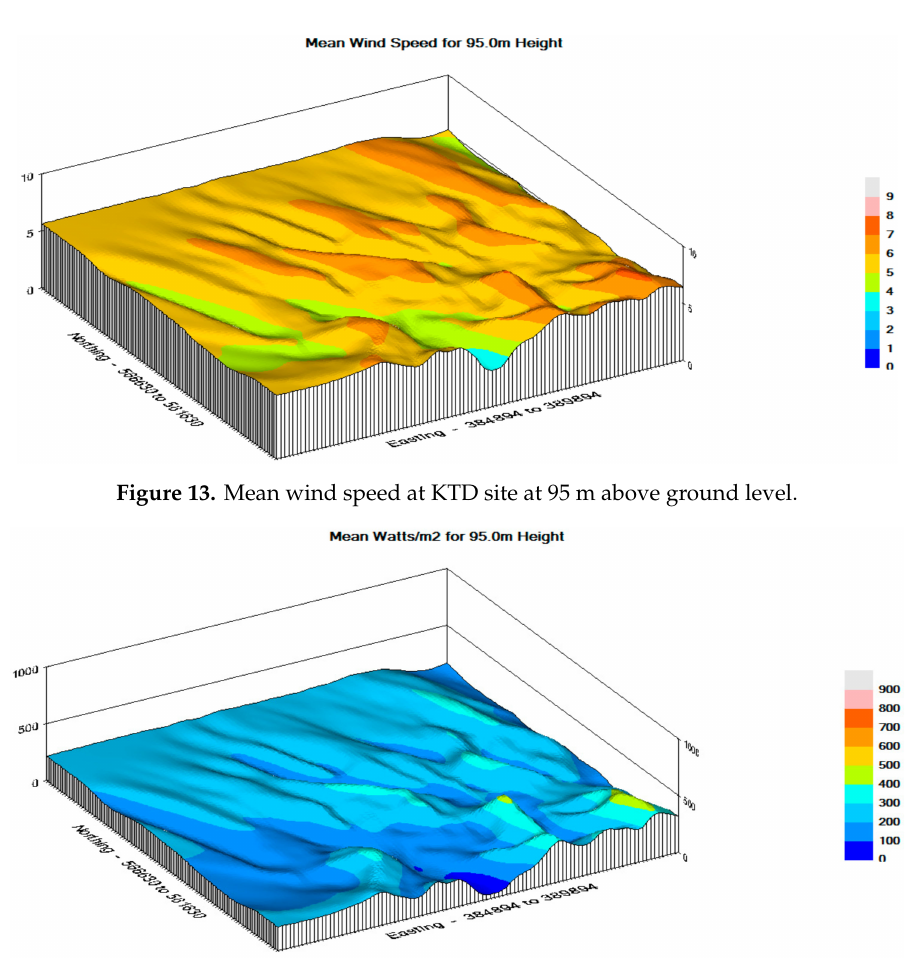
Figure 14. Mean power density at KTD site at 95 m above ground